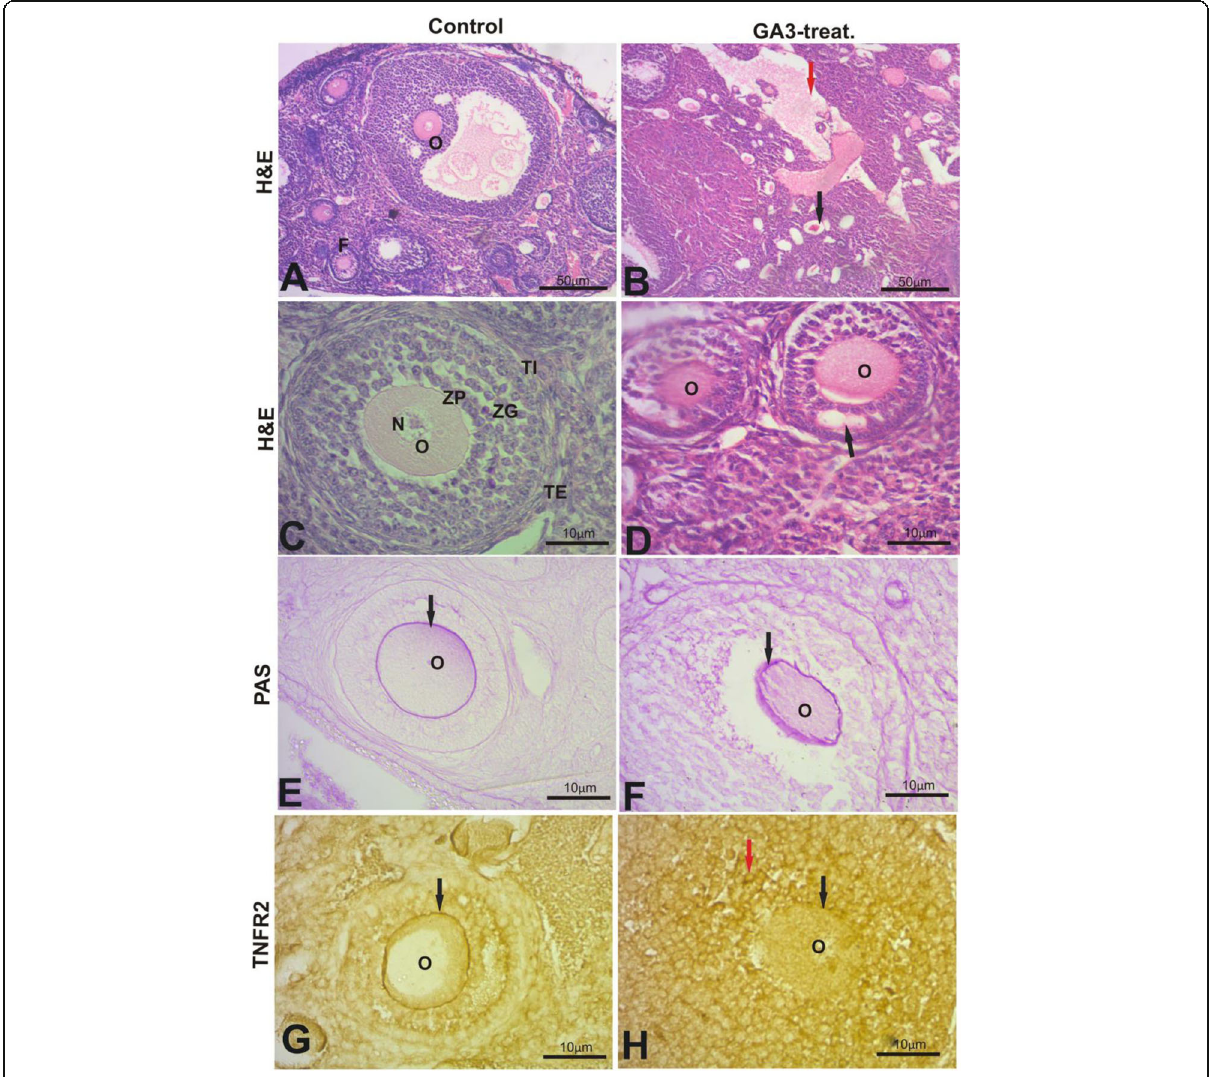
Fig. 3 Photomicrographs of H&E-, PAS-, and TNFR2 immuno-stained sections in the ovary. Normal histological structure was observed in control ovary ( a , c ). GA3-treated group showed congestion of blood vessel (red arrow, b ), degeneration of the follicles (black arrow, b ), and vacuolation (black arrow, d ). GA3-treated group showed alteration in the carbohydrates content (PAS) (arrow, f ) as compared to the normal localization in the zona pellucida of control ovary (arrow, e ). TNFR2 expression was detected in the zona pellucida of control ovary (arrow, g ), whereas GA3-treated ovary showed undistinguished TNFR2 expression in zona pellucida (black arrow, h ) with increase the TNFR2 expression in zona granulosa cells (red arrow, h ). O, oocyte; F, follicle; N, nucleus; ZP, zona pellucida; ZG, zona granulose; TI, theca interna; TE, theca externa. Scale bar = 50 μ m ( a , b ) and 10 μ m ( c – h